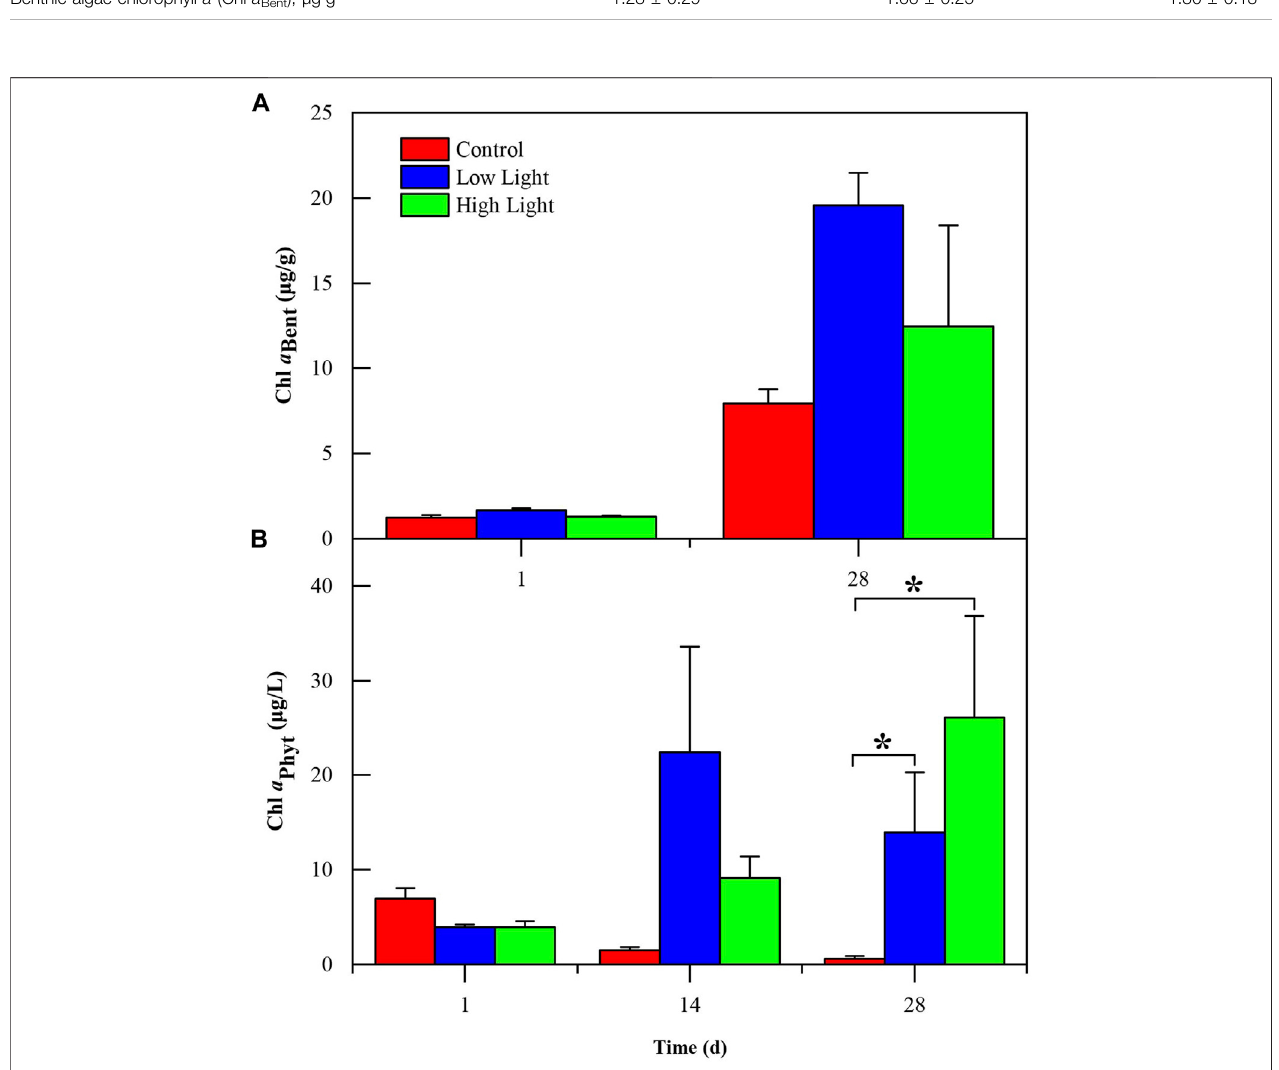
FIGURE 2 | Phytoplankton chlorophyll a (Chl a Phyt ) (mean ± SE) (A) and benthic algae chlorophyll a (Chl a Bent ) (B) in various treatments during the experiment. The label ( * ) indicates signi fi cant differences ( p < 0.05) among treatments.